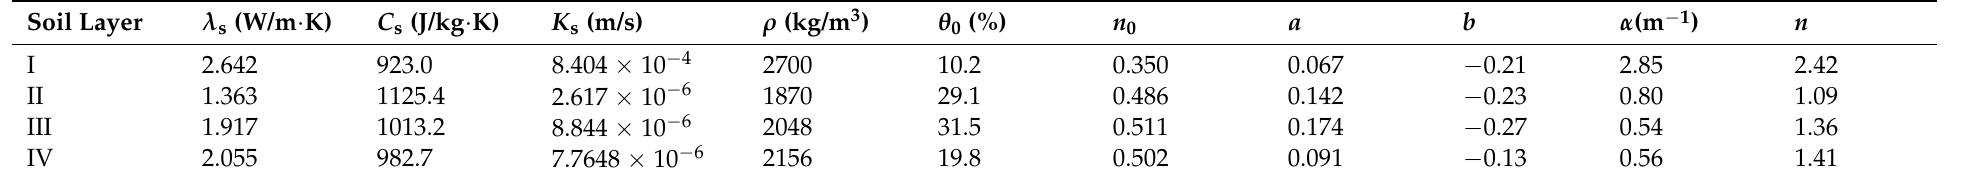
Table 2. Physical parameters of the soil layers.